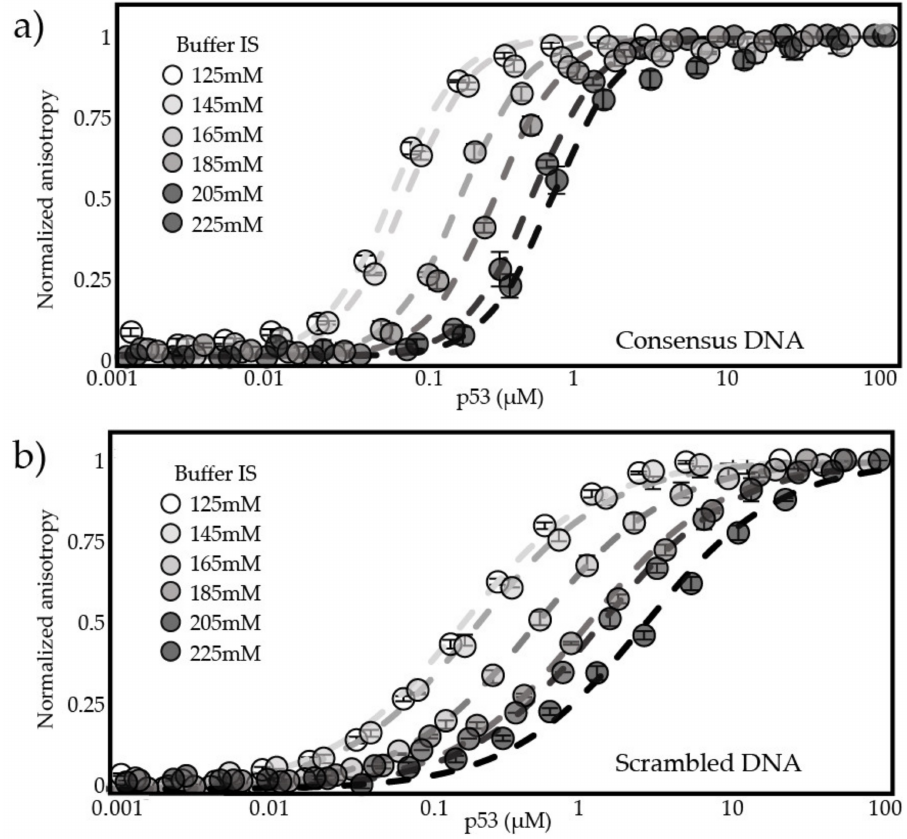
Figure 2. DBD binds DNA across IS. Fluorescence anisotropy plots show the change in signal from a fluorescently tagged DNA fragment as protein is added: an increase in the concentration of p53 needed to achieve saturation when DNA concentration is kept stable as buffer salt concentration increases. ( a ) fluorescence anisotropy plots of DBD bound to consensus DNA at 125–225 mM IS; ( b ) fluorescence anisotropy plots of DBD bound to scrambled DNA at 125–225 mM IS. 3.2. DBD, ND, and ND Mutants Binding to Consensus and Scrambled DNA at Physiological